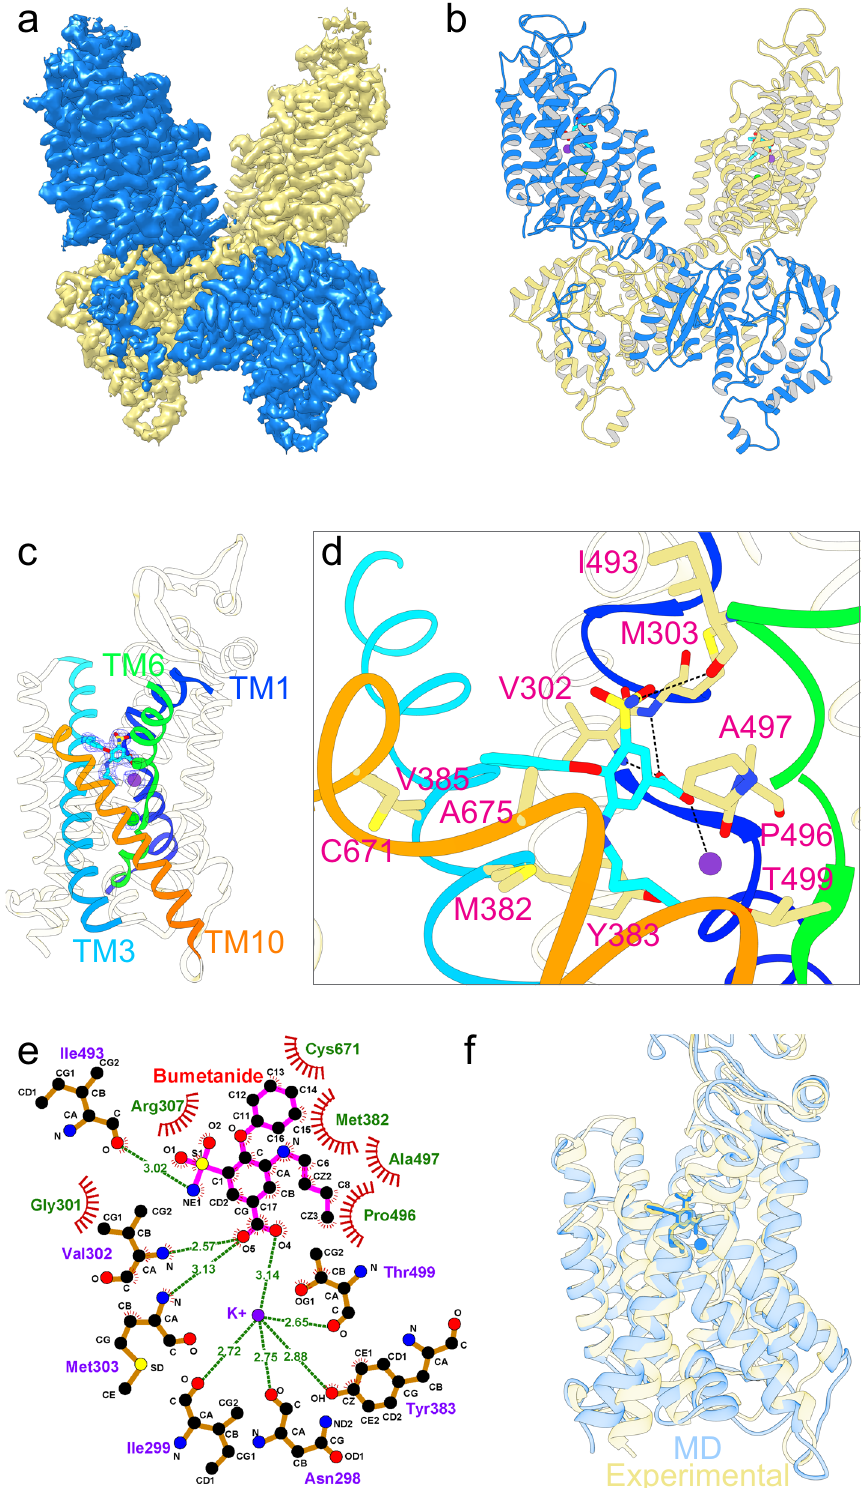
Fig. 1 Bumetanide binds to the extracellular entryway of NKCC1. Overall architecture of human NKCC1 bound with bumetanide shown in map ( a )